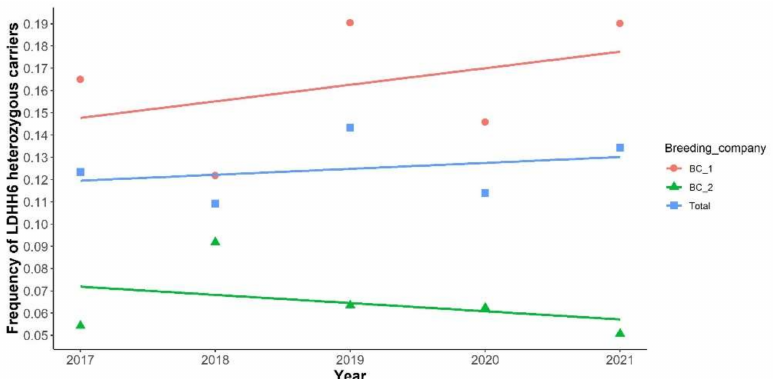
Figure 2. Evolution of LDHH6 heterozygous carrier frequency between 2017 and 2021 in dairy Lacaune male lambs. The frequency is indicated either for all candidates to genomic selection (Total) or depending on the breeding company (BC_1 or